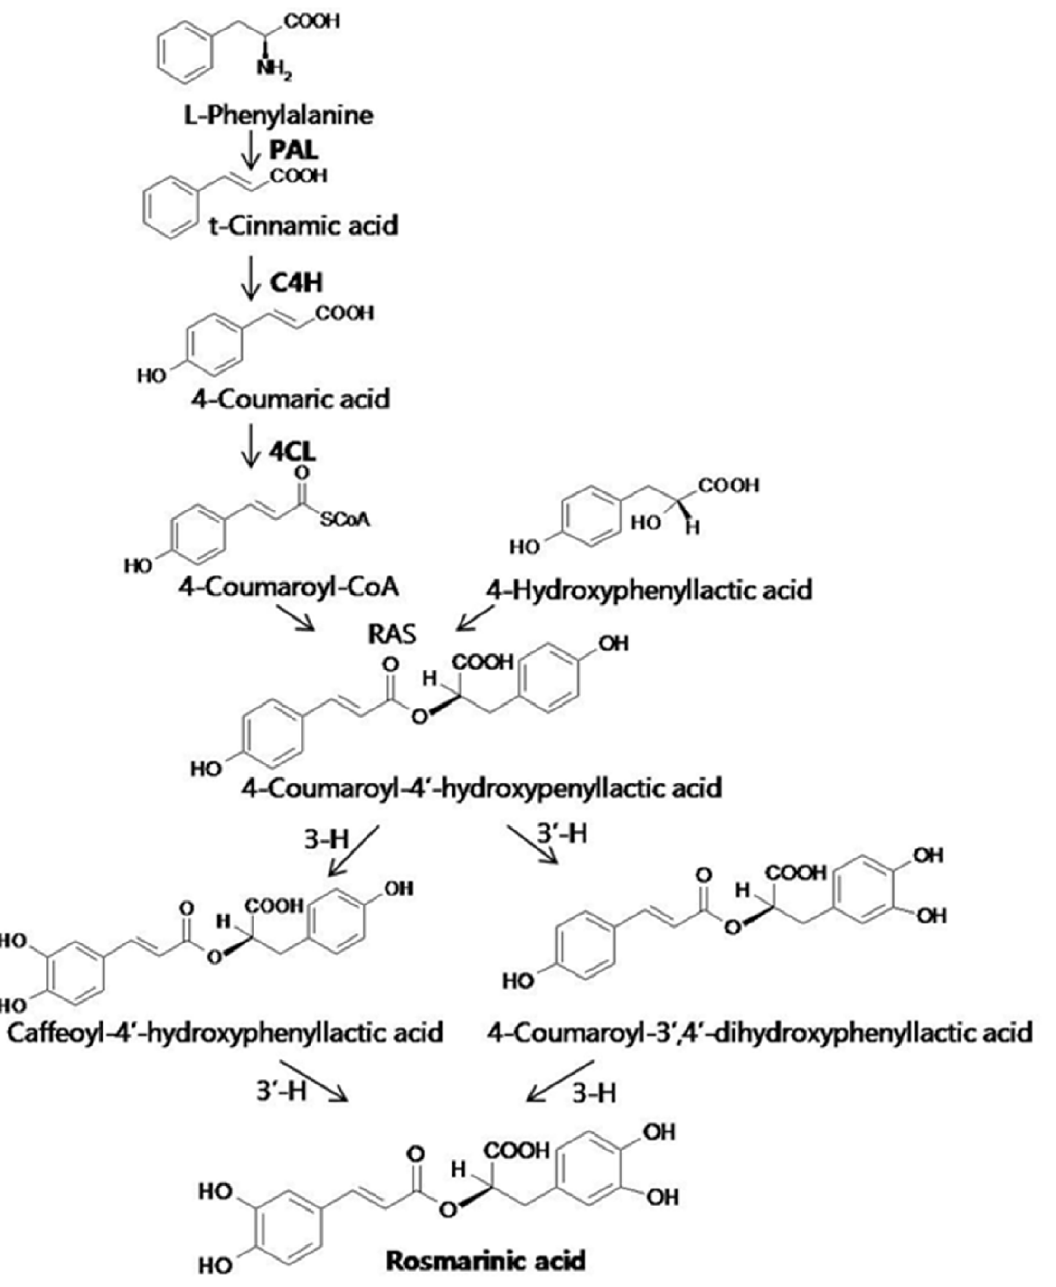
Figure 1. Proposed biosynthetic pathway of rosmarinic acid. PAL, phenylalanine ammonia-lyase; C4H, cinnamate 4-hydroxylase; 4CL, 4- coumaryl-CoA ligase; RAS, hydroxycinnamoyl-CoA:hydroxyphenyllactate hydroxycinnamoyl